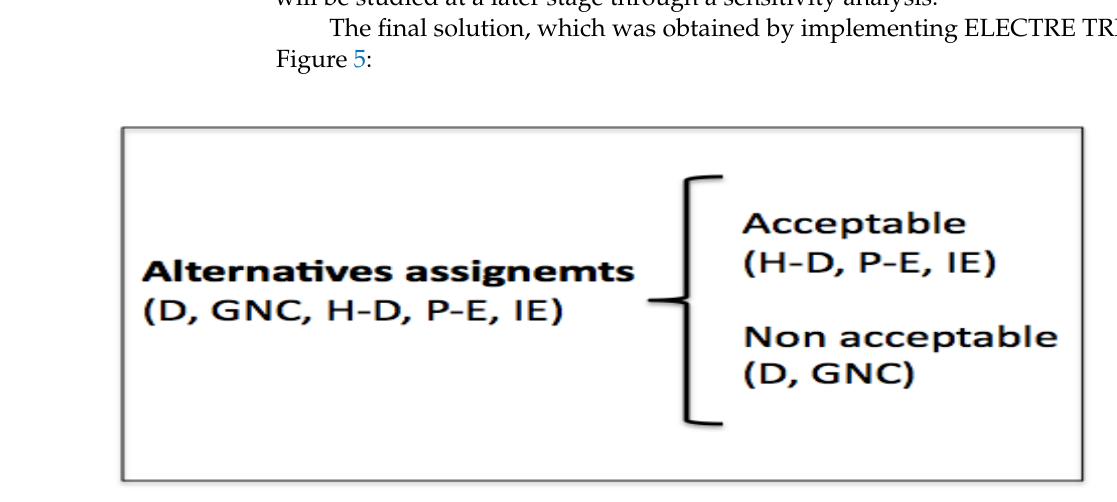
Figure 5. The ELECTRE TRI solution.